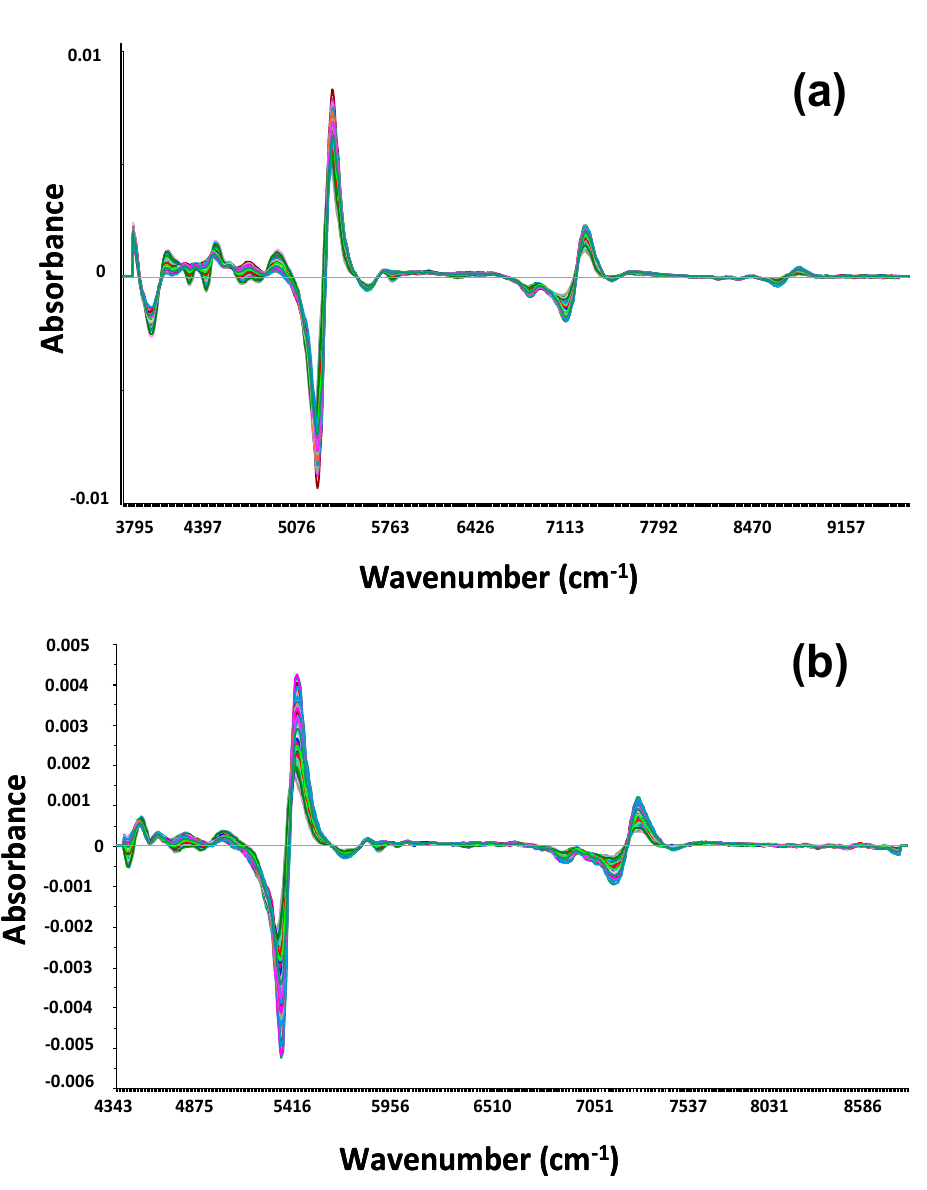
Figure 6. Optimized near-infrared (NIR) spectra in fresh pasture samples: ( a ) for pasture moisture content (PMC) using SNV with 2nd derivative spectral preprocessing; and ( b ) for crude protein (CP) and near detergent fiber (NDF) using 1st derivative spectral preprocessing.